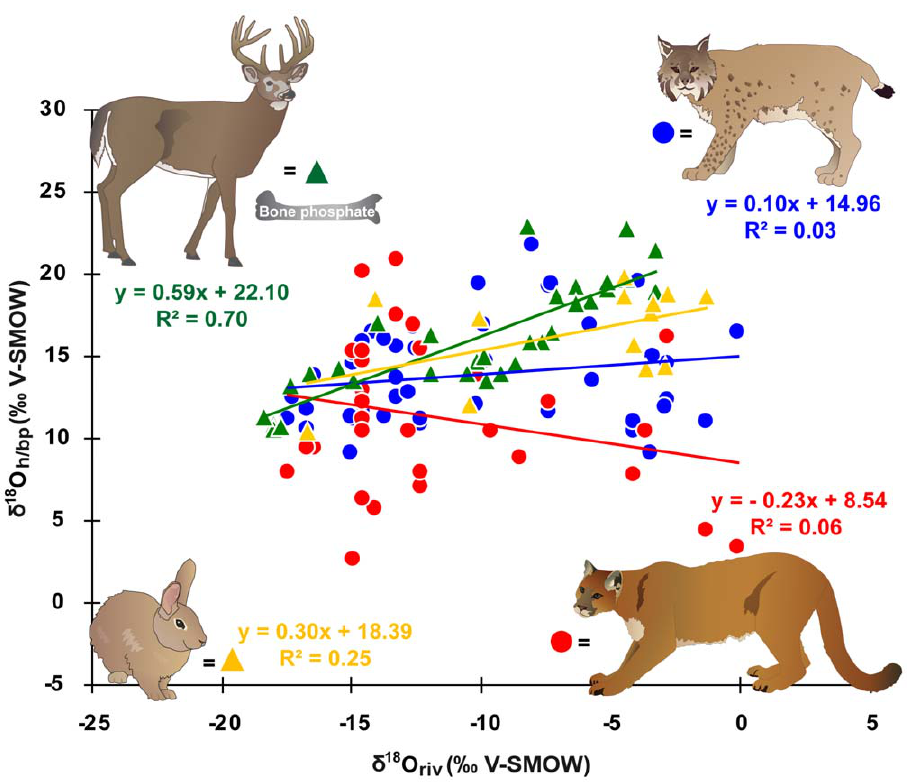
Figure 3. Oxygen isotope values of keratin relative to river water. Plot of d 18 O of hair ( d 18 O h ) from bobcat, puma and eastern cottontail rabbit and bone phosphate ( d 18 O bp ) from white-tailed deer* vs. mean annual d 18 O of river water ( d 18 O riv ) (*data from [56]).